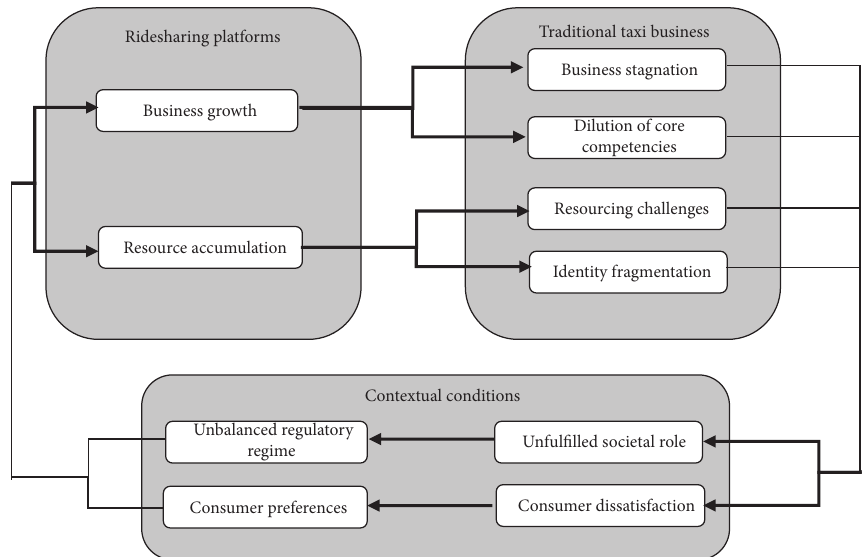
Figure 1: The negative economic and social implications of